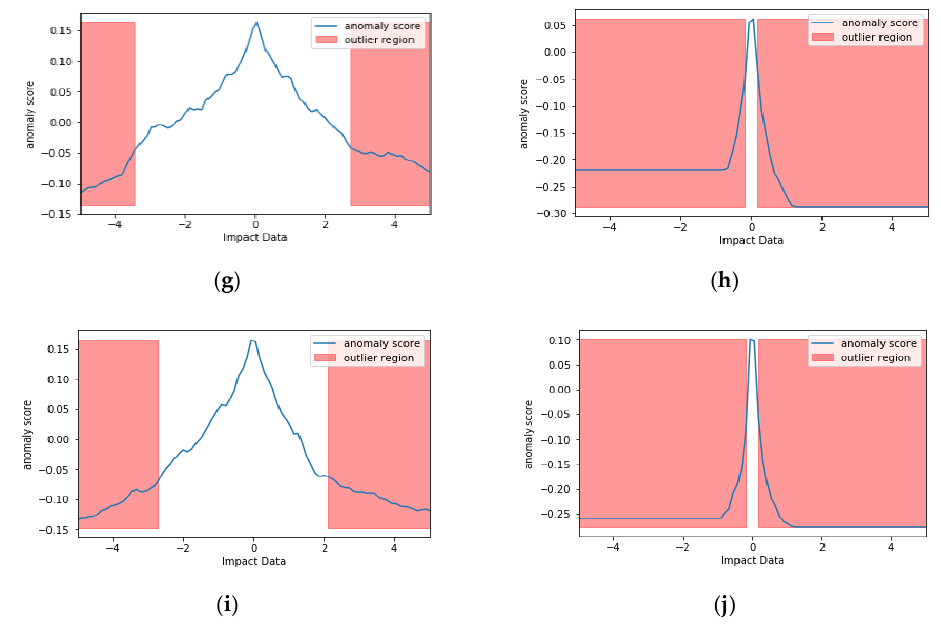
Figure 6. The red area indicates outliers within sensor data as follows: ( a , b ) IF analysis for sensor 1; ( c , d ) IF analysis for sensor 2; ( e , f ) IF analysis for sensor 3; ( g , h ) IF analysis for sensor 7; ( i , j ) IF analysis for sensor 8. Impact data refers to the voltage data from the sensors. Note the constant anomaly score on the higher voltage impact data on the noisy data.